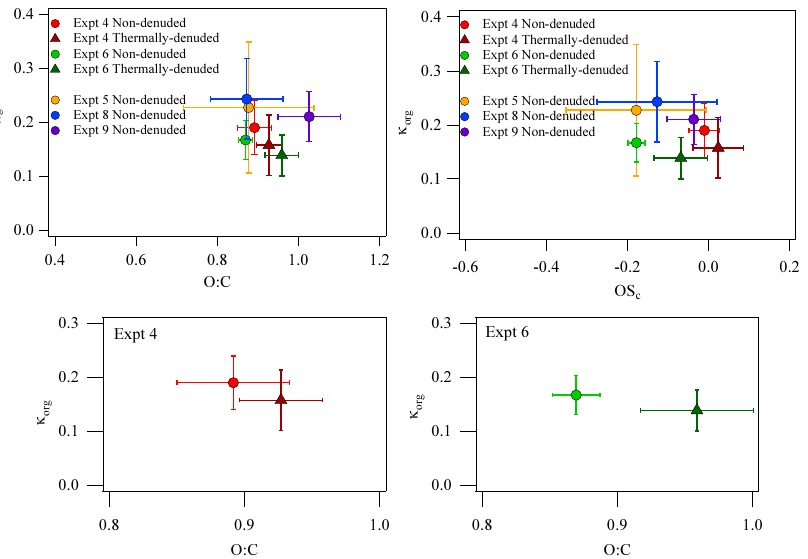
Figure 9. κ org versus O : C (top, left) and OS c (top, right) for all experiments as listed in Table 1. Also shown are magnified hygroscopicity and O : C for unseeded experiments with non-denuded and thermally denuded measurements (bottom). Vertical and horizontal error bars represent the standard deviation in κ org and O : C or OS c ,